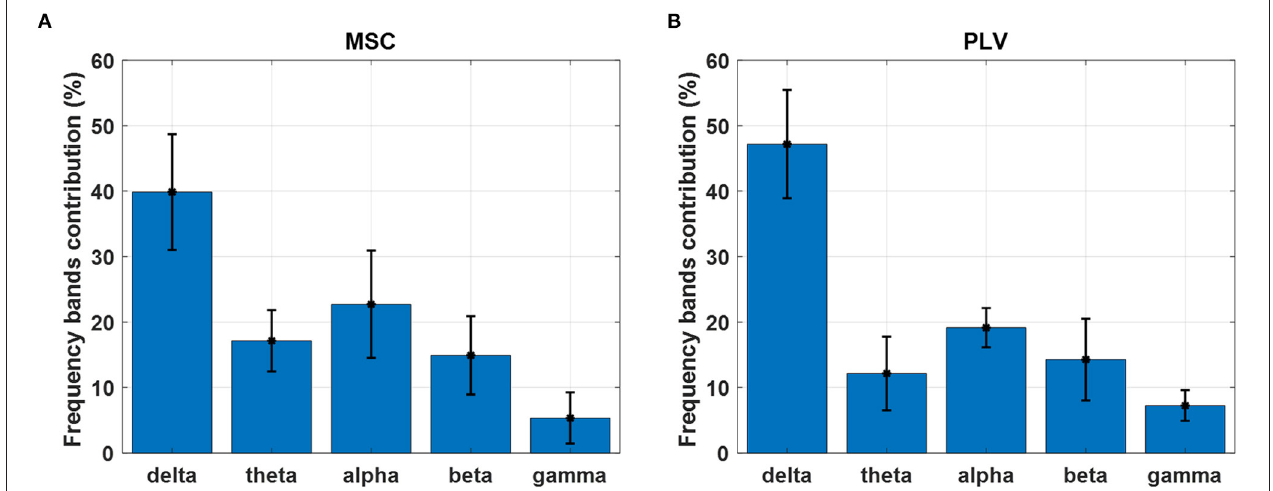
FIGURE 8 | Contribution of each frequency band in movement decoding with (A) MSC and (B) PLV features. Each bar displays contribution weights’ mean and standard deviation in each frequency